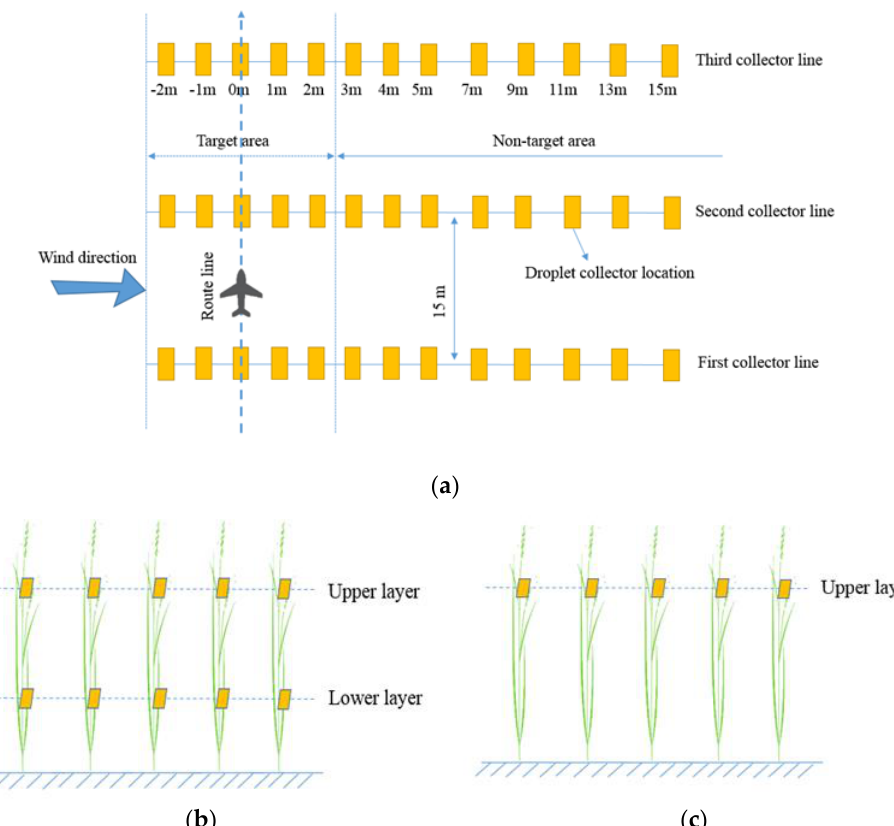
Figure 2. ( a ) Overall experimental layout of each treatment; ( b ) Placement of Mylar cards at target area; and ( c ) Placement of Mylar cards at non-target area.